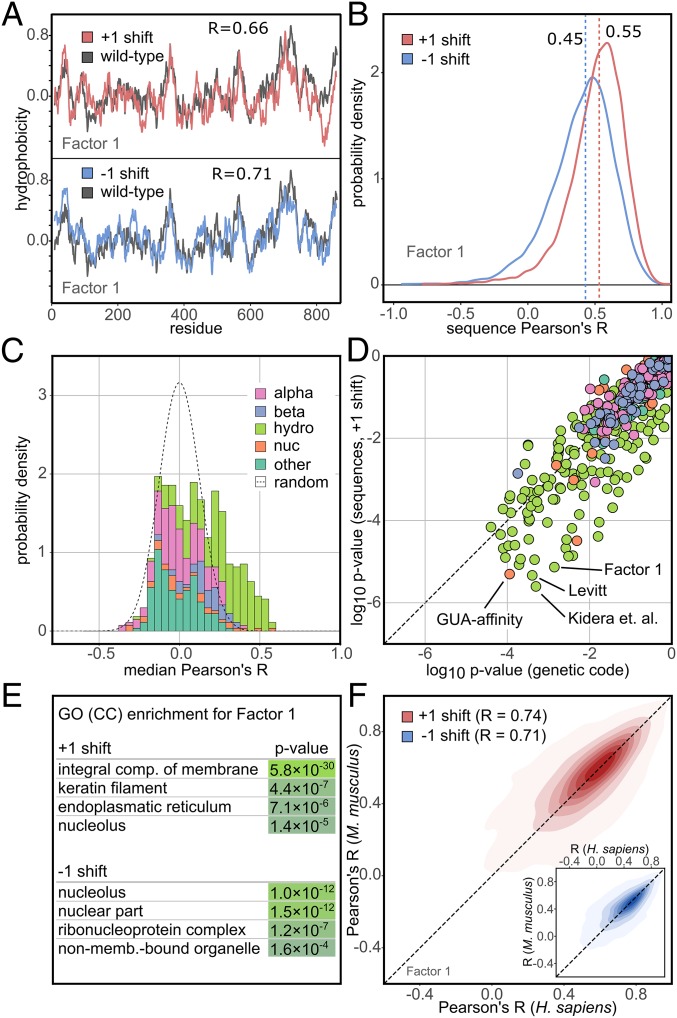
Frameshifting at the level of protein sequences. (A) Comparison of wild-type and +1 (Upper, red) and −1 (Lower, blue) frameshifted Factor 1 hydrophobicity profiles for Ser/Thr phosphatase 4 regulatory subunit 4 protein (UniProtID Q6NUP7) with the associated Pearson’s Rs. (B) Distributions of Pearson’s R for wild-type vs. +1 frameshift (red) and wild-type vs. −1 frameshift (blue) for Factor 1 over all human proteins (n = 17,083) with their medians indicated. (C) Histogram of median Pearson’s R for 604 scales when comparing wild-type and +1 frameshifted profiles in human for all investigated scales, grouped by category and presented as a stacked, normalized histogram. The expected density derived via a random model is shown as a dashed line. (D) Comparison of P values for frameshifting at the level of UGC and +1 frameshifted human sequences for 604 studied scales. (E) Enrichment of GO cellular compartment (CC) terms in the top quartile of human sequences according to Pearson’s Rs between wild-type and +1 or −1 frameshifted Factor 1 profiles (low P values: light green; high P values: dark green). (F) Comparison of Pearson’s Rs (wild-type vs. +1 frameshifted Factor 1 profiles) between orthologous proteins in H. sapiens and M. musculus (n = 12,174; R = 0.74). The same is shown for −1 frameshifts in the Inset (n = 12,174; R = 0.71).